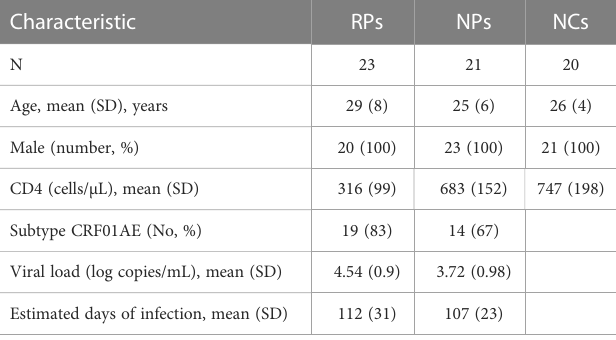
TABLE 1 Clinical characteristics of patients with early HIV infection and HIV negative controls.